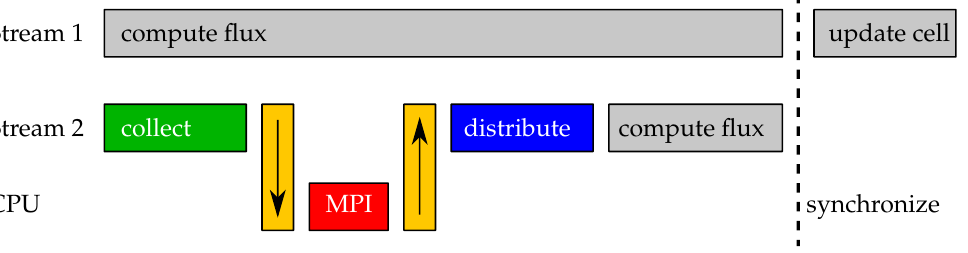
Figure 2. Multi-GPGPU communication hiding: The cell faces independent of the receive ghost cells are processed concurrently with the communication and the evaluation of the remaining cell